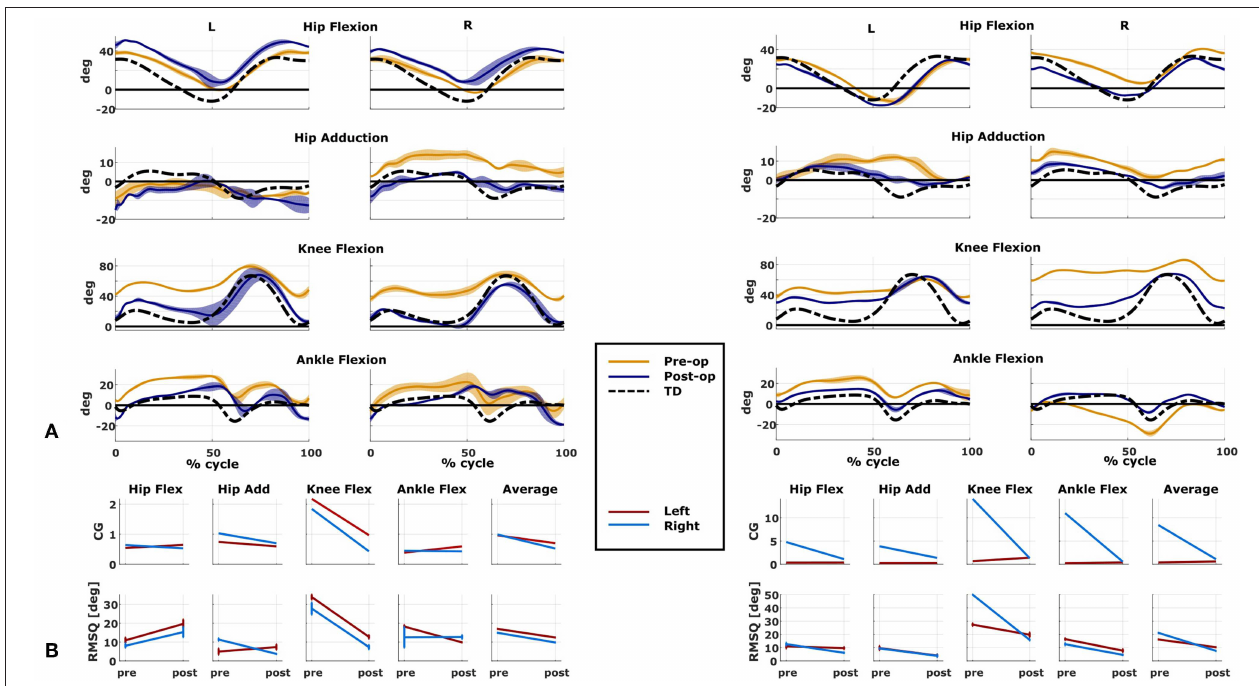
FIGURE 6 | Predicted and measured changes in patient performance. Data on the left belong to Patient 1, on the right to Patient 2. (A) Kinematics of the two representative cases measured in both pre- and post-operative conditions (mean and standard deviation). Black dotted line is the average data from typically developed (TD) children used as reference for the computation of the capability gap (CG). (B) Changes in the predicted capability gap, and in the root mean square differences (computed with respect to the TD kinematics) between the pre- and post-operative